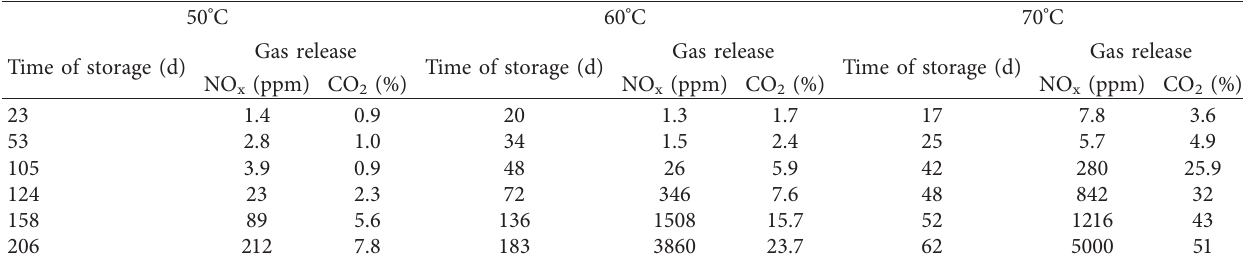
Table 1: Gas release during accelerated aging of the NEPE